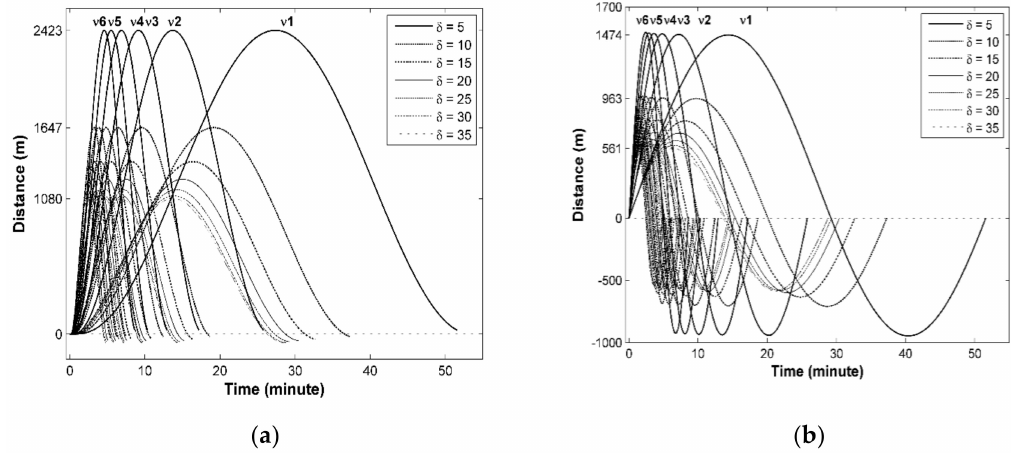
Figure 7. x- and y- positions of measured OS trajectories vs. turning time: ( a ) x-coordinate; ( b ) y-coordinate: vessel’s velocities: v1–v6 and rudder